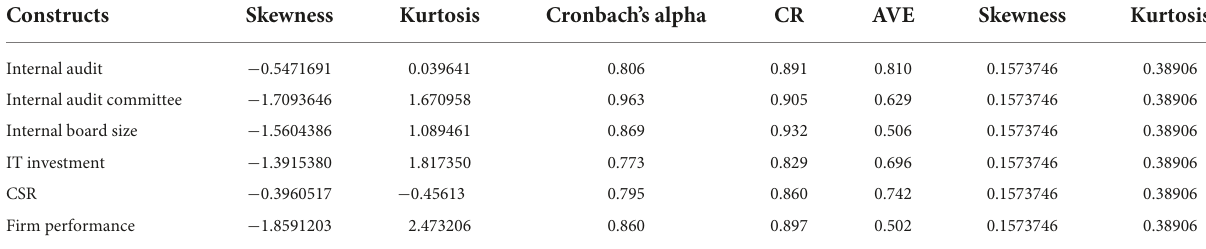
TABLE 1 Reliability, validity, and descriptive of the